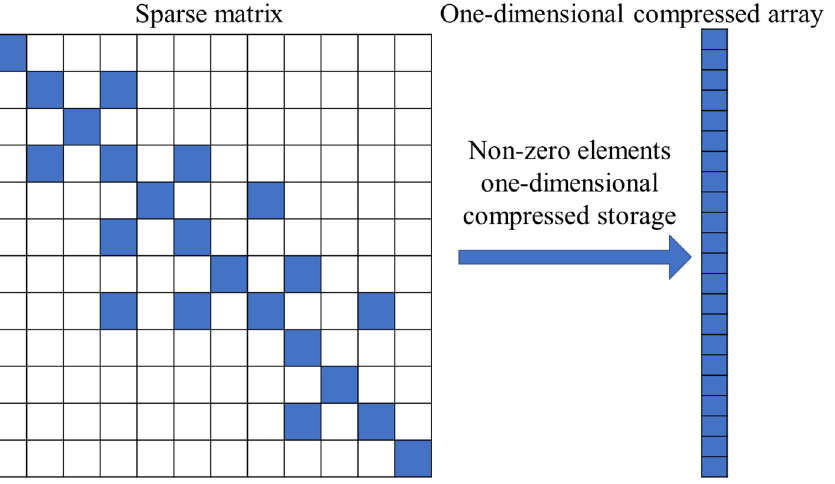
Figure 1. Schematic diagram of the non-zero element compressed storage method for sparse matrix.